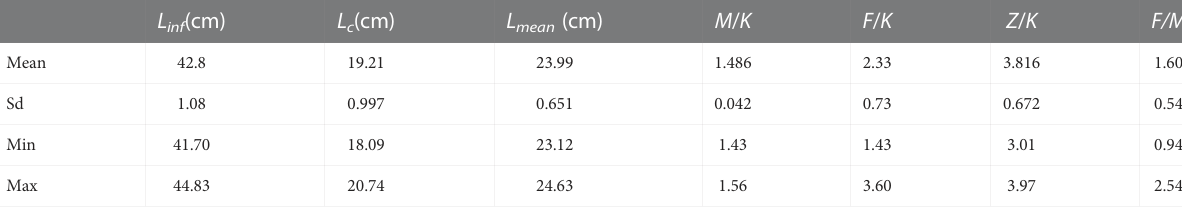
TABLE 2 Population parameters of T. lepturus estimated by LBB.